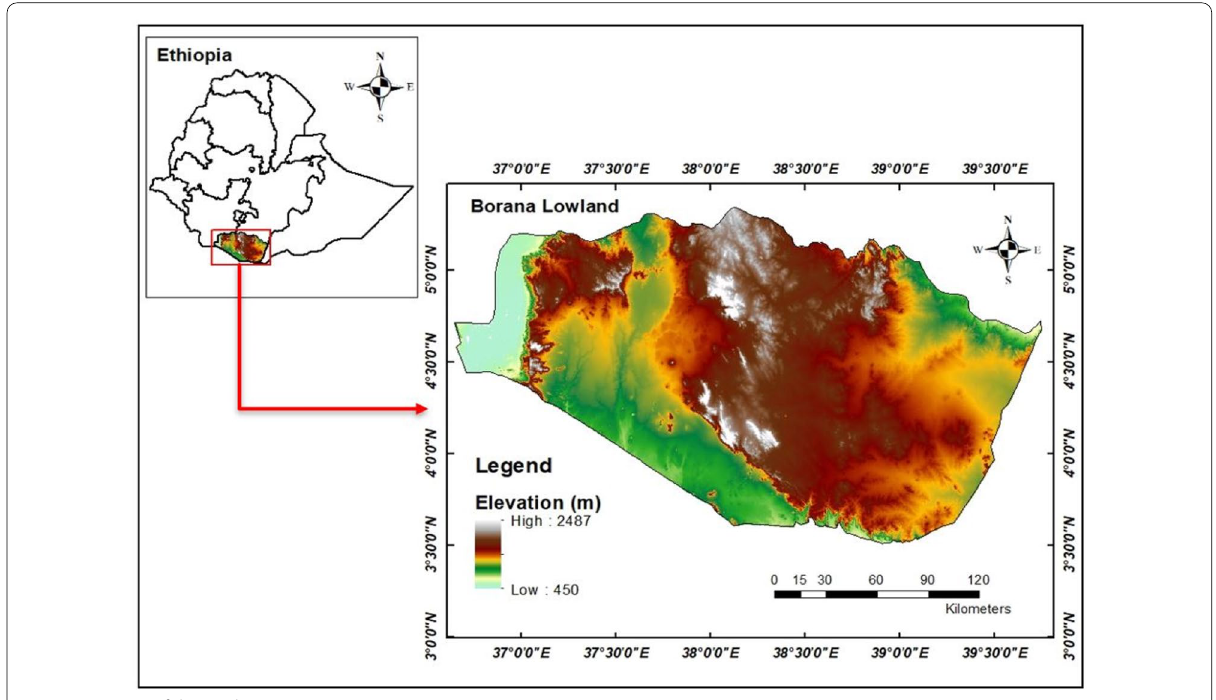
Fig. 1 Location of the study area